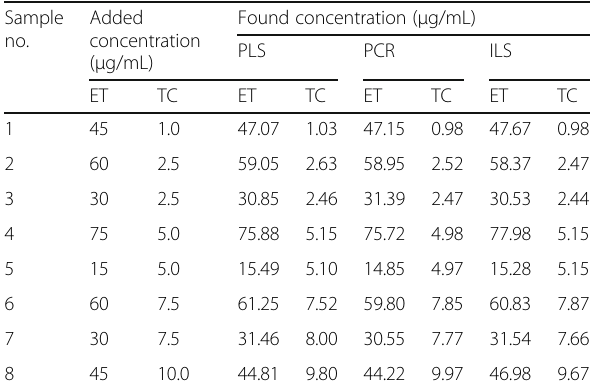
Table 2 Analysis results of ET and TC in the validation set using multivariate calibration methods (PLS, PCR, and ILS) Sample